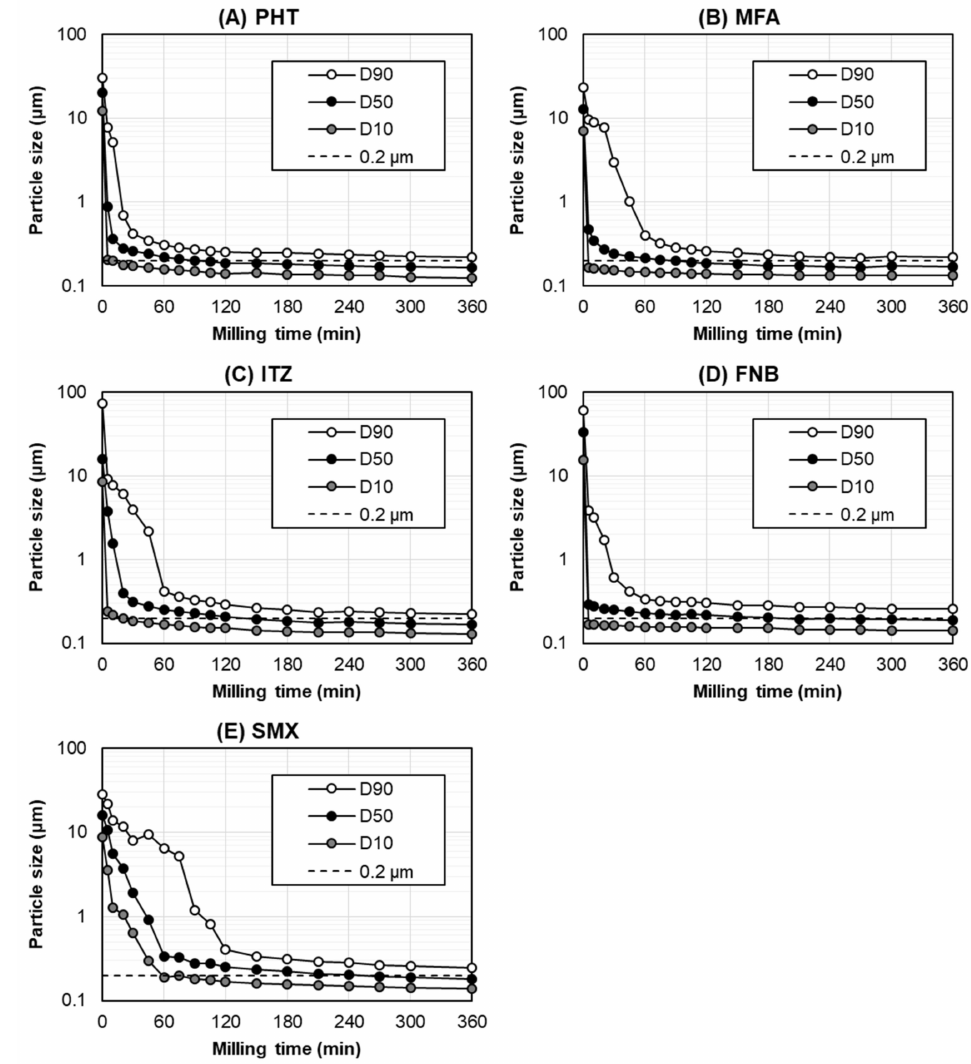
Figure 3. The particle size transition of ( A ) PHT, ( B ) MFA, ( C ) ITZ, ( D ) FNB, and ( E ) SMX as a function of the bead-milling